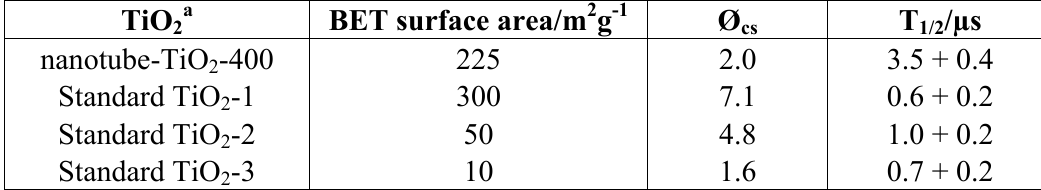
Table 1. Surface area and photophysical data obtained by laser flash photolysis of nanotube-TiO and other TiO materials. Reproduced by permission of the Royal Society 2 2 of Chemistry from reference